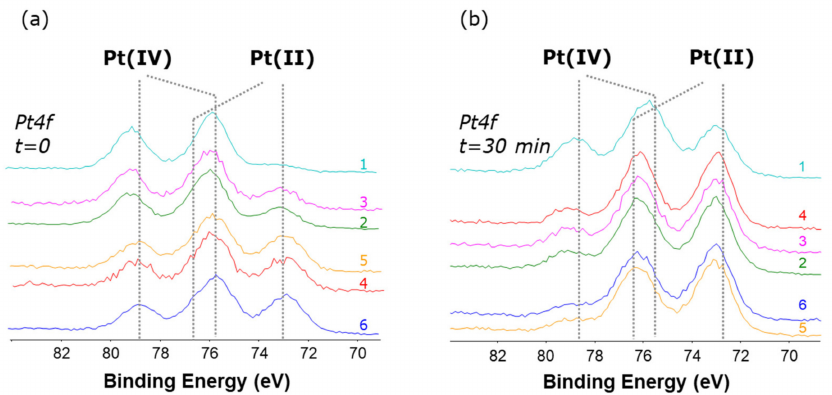
Figure 8. Pt4f XP spectra for complexes 1 – 6 ( a ) acquired at the onset of the experiments and ( b ) after 30 min irradiation. On each spectrum is shown the number that identifies the complex.